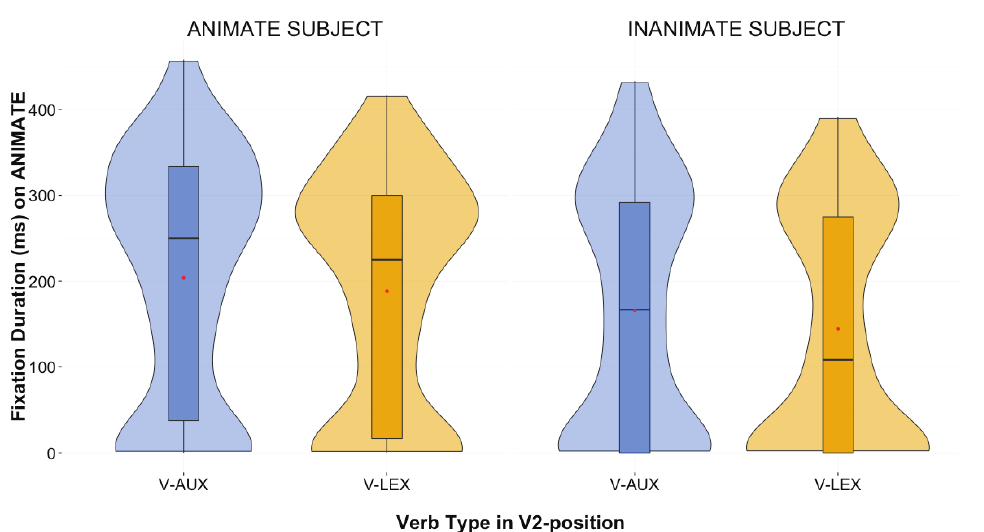
Figure 6: Violin/boxplot of fixation duration to the animate referent per condition in the late subject integration window. The red dot encodes the mean, the black vertical line encodes the median, the top and bottom edges of the box encode the interquartile range and the transparent beans provide a density plot. Note that the statistical analysis was performed on the logit-transformed odds ratio of fixations to the animate referent over those to the inanimate